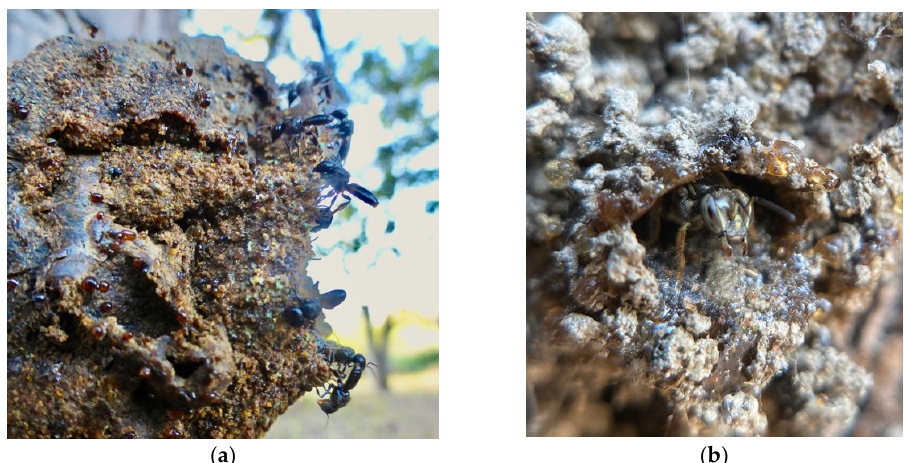
Figure 3. Many stingless bee species surround their nest entrances with ( a ) a barrier of resin droplets ( b ) or a continuous layer of resin to repel and trap would-be intruders. Photos by Héctor Morales Urbina.